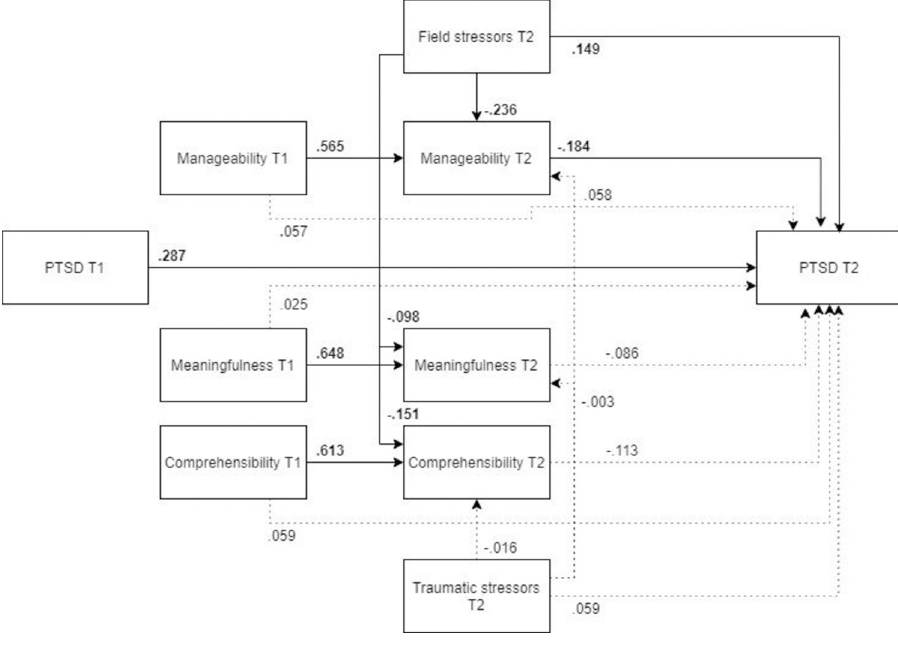
Fig 14. Tested structural equation model for PTSD.